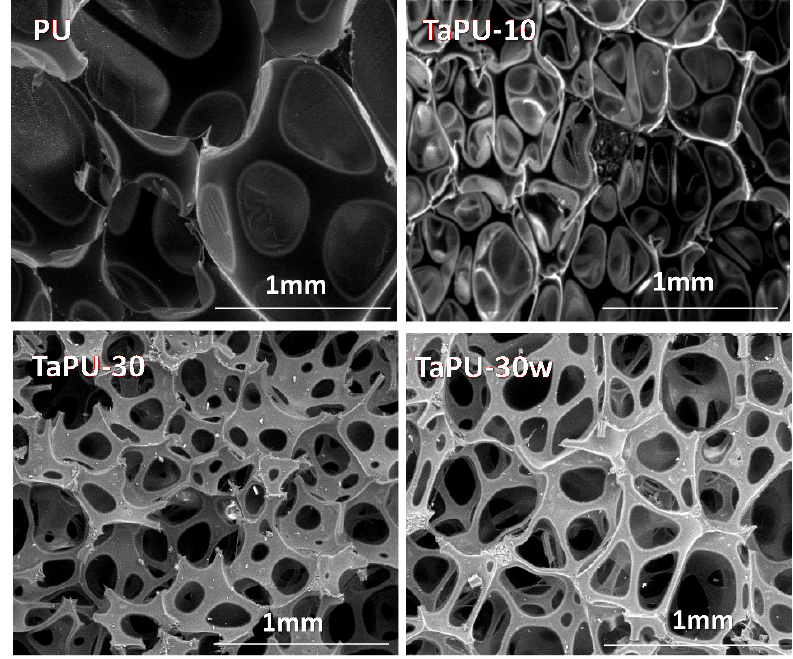
Figure 4. SEM images of PU, TaPU-10, TaPU-30, and TaPU-30w foams.